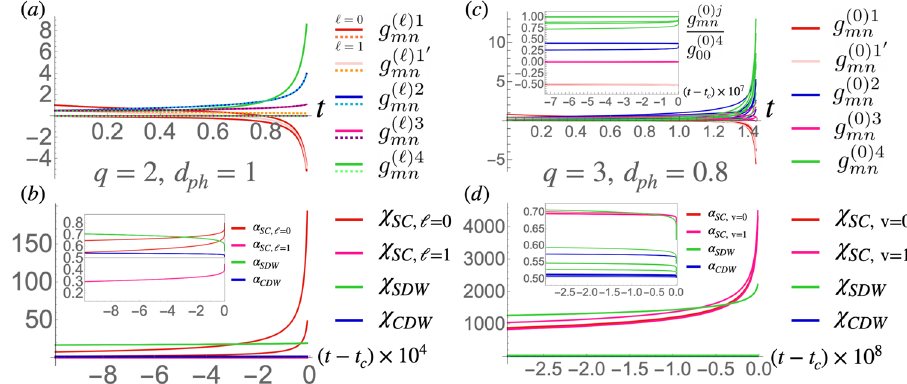
Fig. 2 | RG fl ow of coupling constants and susceptibilities. The fl ow of the g 1 = g 1 0 ). b q =2 RG fl ow of the susceptibilities χ I with I corresponding to SC with ^ y ( ℓ =1, coupling constants g ð ‘ Þ j mn with ℓ =0,1 (solid and dashed lines, respectively), Cooper pairs with zero momentum ( ℓ =0, red) or momentum Q = 2 π p q magenta), SDW (green) or CDW (blue). Initially χ SDW is the fastest growing sus- j =1,1 0 ,2,3,4 (red, light red, blue, magenta, and green, respectively), and m , n = 0, … , q − 1areshownfor a q =2at1/4 fi llingatperfectnesting d ph =1;andfor c q =3 ceptibility,buteventuallyThe ℓ =0SCsusceptibilitytakesover.Theinsetshowsthe (cid:2) (cid:3) χ = 2 for the same range of RG at1/6 fi llingwith d ph =0.8( U =1inarbitraryunitsinallplots).Theinstabilityoccurs corresponding critical exponents α I = 1 (cid:1) log t I c (cid:1) t at t c =0.98 and t c =1.46 for q =2 and 3, respectively. The fl ows for q =2 and 3 are times t . The largest exponent at the end of the fl ow is α SC , ℓ =0 ( t c ) ≈ 0.73. ( d ) Shows otherwisequalitativelysimilar,andbotharesimilartothe fl owintheabsenceofthe that analogous plots for q =3, but in this case the ℓ =0 and 1 SC channels are magnetic fi eld: note that while all coupling constants are initially positive or van- degenerate so only the former is plotted; in this case red and magenta colors ishing, g ð 0 Þ 1 mn and g ð 0 Þ 1 0 mn eventually change sign, leading to effective attraction in the indicatethesuscpetibilitiesatv=0and1VHSpoints,respectively,whichcontribute pairingchannel.Theinsetin c showsthe q =3 fl ownormalizedby g ð 0 Þ 4 00 whichshows ffiffiffi p isreachedattheendofthe fl ow,as thattheself-similar fi xedtrajectory g ð ‘ Þ j mn = g j = Color q indicated by curves of the same color approaching the same value (we also fi nd